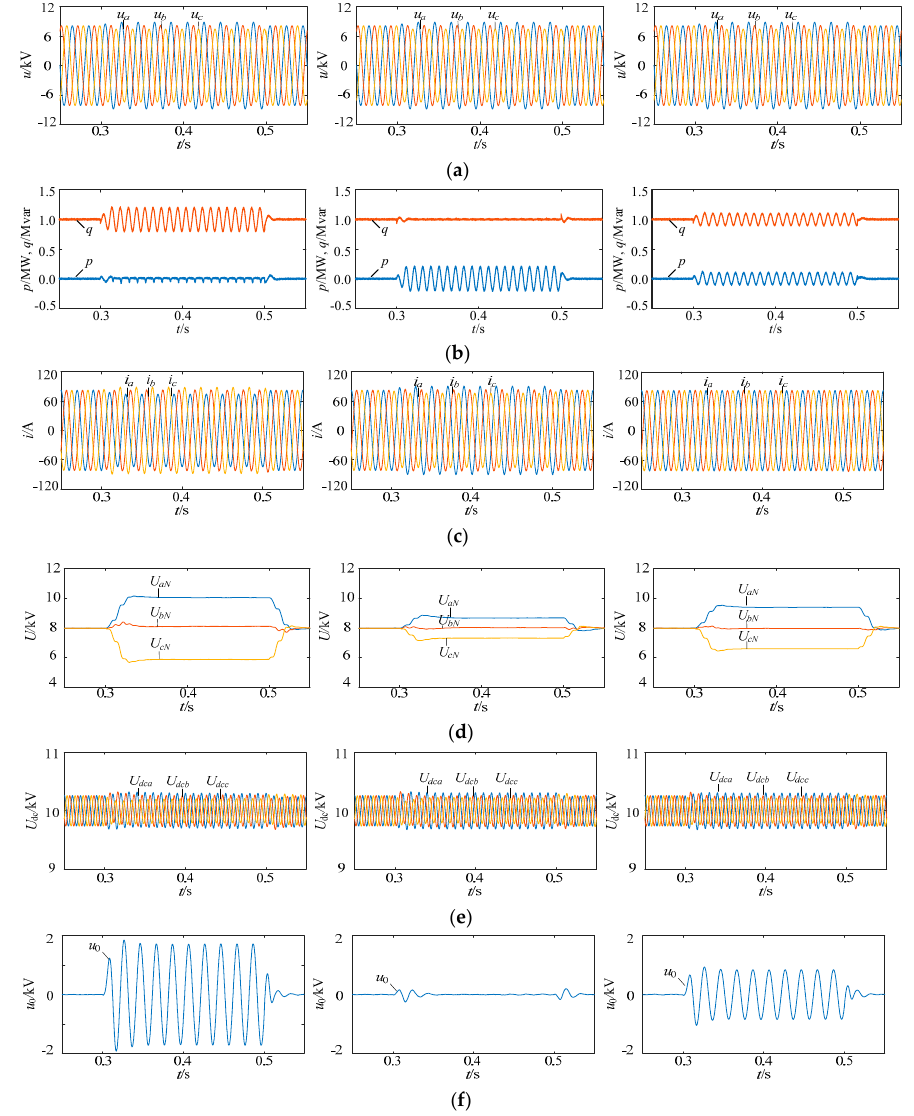
Figure 9. Simulation results of star-connected SVG. APOE in the left. RPOE in the middle. BPSC in the right. ( a ) Grid voltages. ( b ) Active and reactive power. ( c ) Phase currents of SVG. ( d ) Three-phase voltage amplitudes. ( e ) Zero-sequence voltages. ( f ) Sub-module capacitor voltages of each phase cluster.